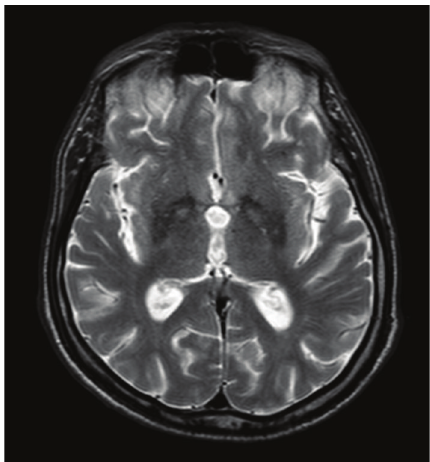
Figure 1: Axial T2 weighted MRI image showing “eye of the tiger” sign with bilateral hypointense rim of globus pallidus and area of central hyperintensity, in addition to hypointense posterolateral putamen.